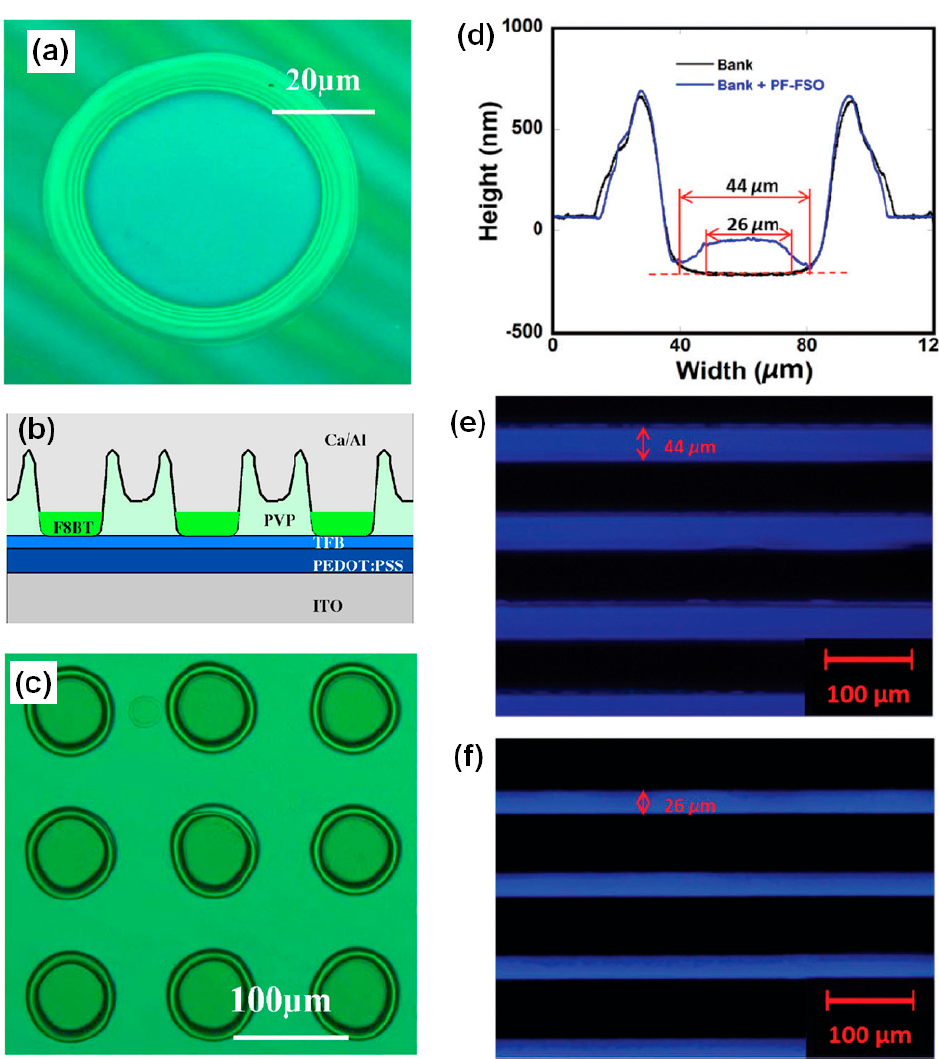
Figure 6. ( a ) A photoluminescence (PL) image of a hole by printing ethanol on a PVP film. ( b ) Schematic showing structure of light emitting diode (LED) with poly(9,9’-dioctylfluorene- co -benzothiadiazole) (F8BT) emissive layer. ( c ) PL image of the fabricated LED array [19]. Copyright 2007 American Institute of Physics. ( d ) Surface profiles of inkjet etched CYTOP bank and inkjet printed poly(dibenzothiophene-S,S-dioxide- co -9,9-dioctyl-2,7-fluorene) (PF-FSO) film. ( e ) PL and ( f ) electro luminance (EL) images of organic light emitting diodes (OLED) based on PF-FSO emissive layer inkjet printed inside of CYTOP bank [31]. Copyright 2017 Royal Society of Chemistry.